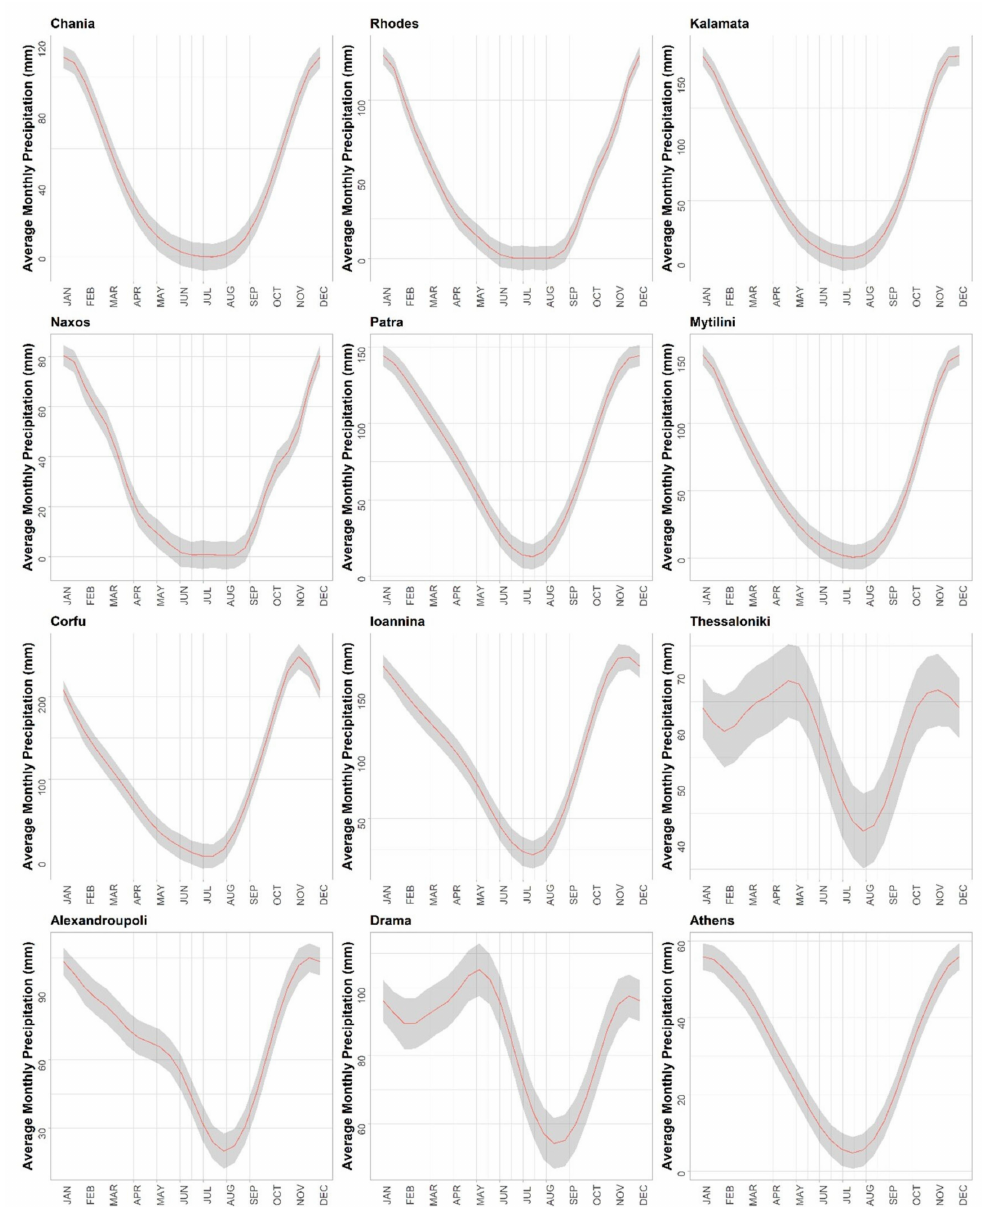
Figure 9. Similar to Figure 8 for fitted intra-annual variation of monthly precipitation (mm). Some negative precipitation values in 95% confidence intervals are not considered as realistic, as they were algorithmically produced by the fitting of